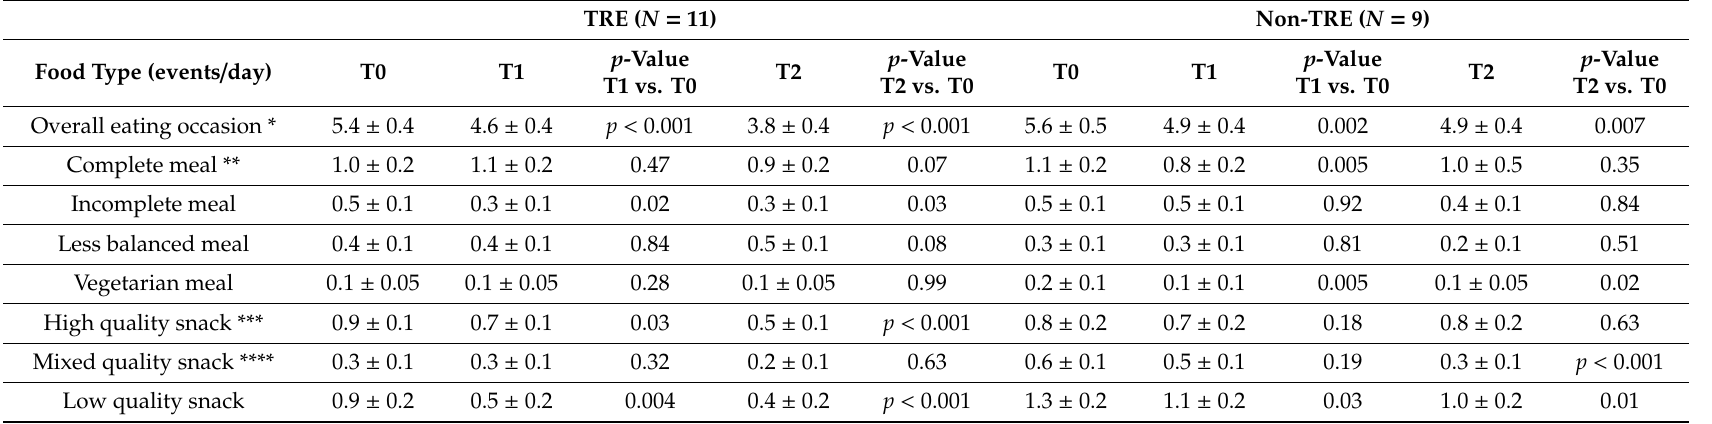
Table 2. Frequency of food types T0, T1, and T2 in the TRE and the non-TRE groups.